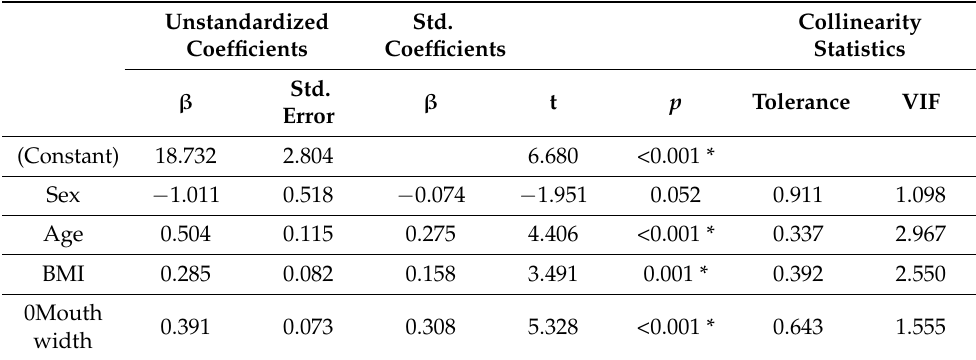
Collinearity Statistics